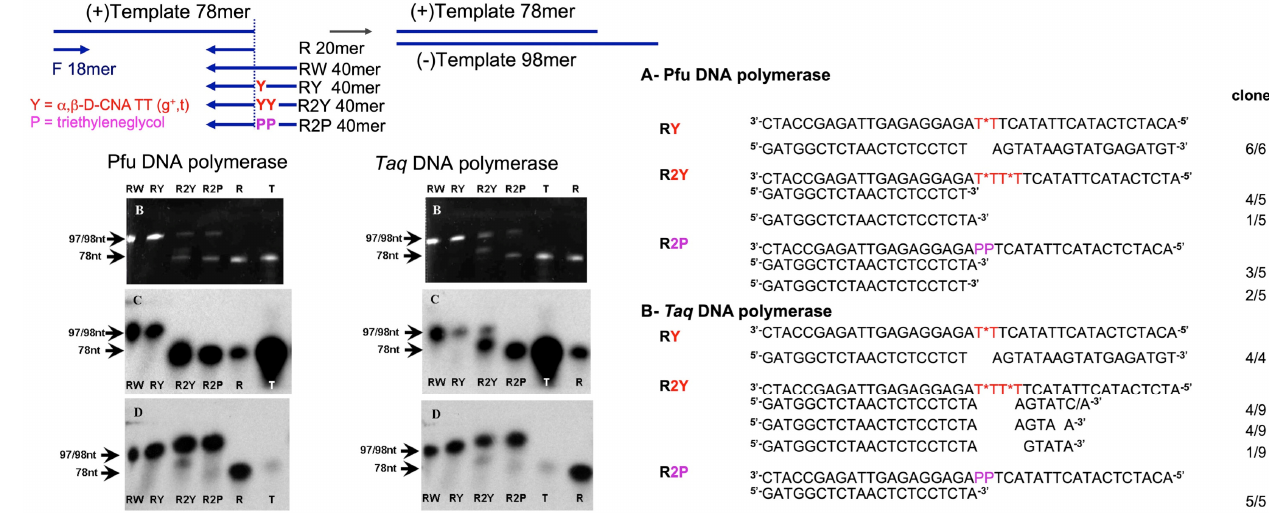
Figure 11. Left: primer design with one or two α , β - D -CNA units (Y) or triethylene glycol unit (P). Gel electrophoresis analysis of PCR products with proof-reading polymerase Pfu, or without proof-reading polymerase Taq . Right: sequencing of terminated PCR products.